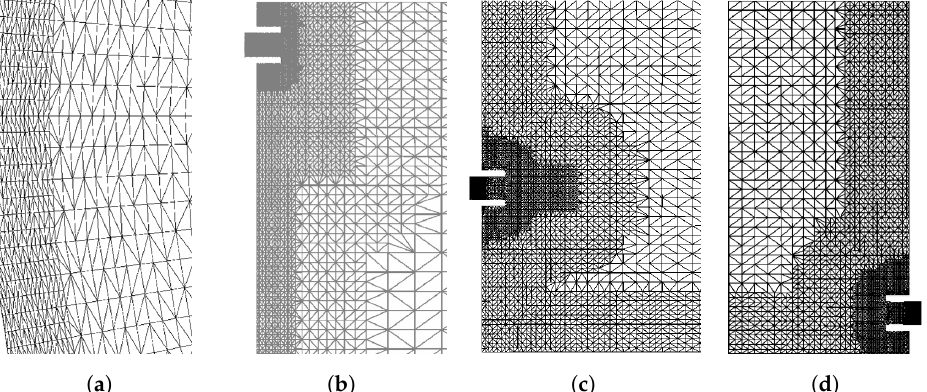
Figure 4. Mesh refinements: ( a ) top view; ( b ) nozzle above the water level; ( c ) nozzle below the water level; and ( d ) outlet